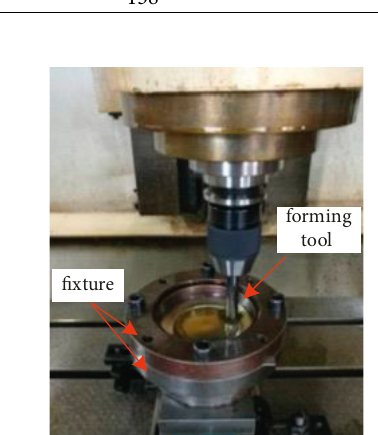
Figure 4: Experimental device.